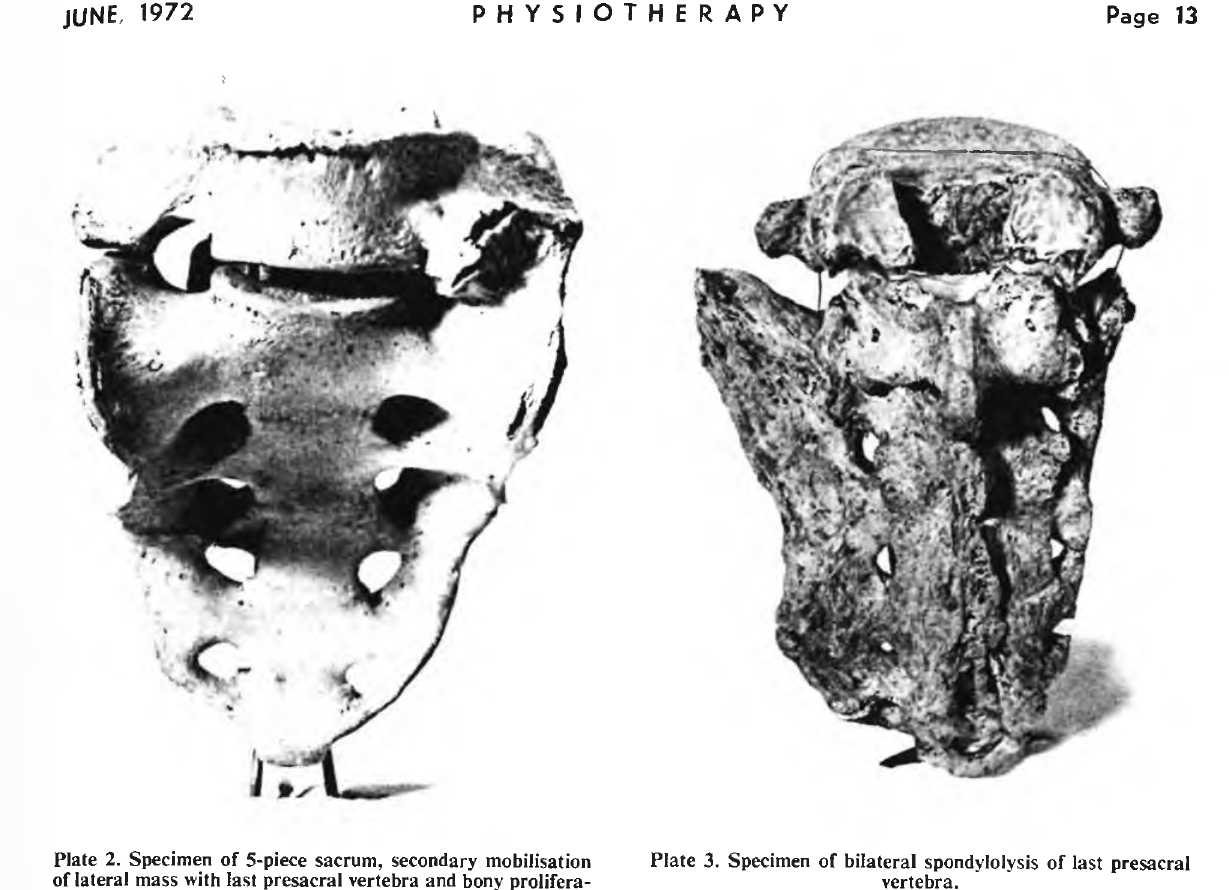
Plate 2. Specimen of 5-piece sacrum, secondary mobilisation of lateral mass with last presacral vertebra and bony prolifera­ tion encroaching on anterior intervertebral foramen on left.